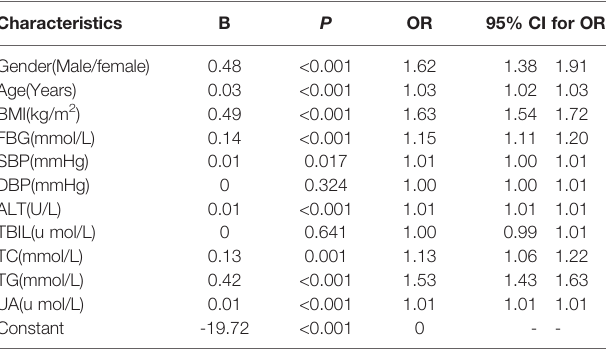
FIGURE 1 | The ROC curve was used to evaluate the diagnostic ef fi cacy of index in the diagnosis of non-obese